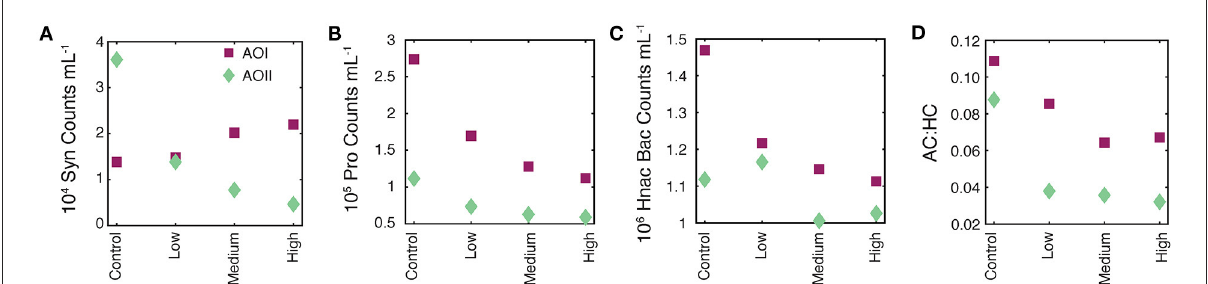
FIGURE3 Flow cytometry data on t 0 samples from all experimental treatments. In all panels, the magenta squares are AOI data and teal diamonds are AOII data. (A) 10 4 Synecococcus counts per mL. (B) 10 5 Prochlorococcus counts per mL. (C) 10 6 high nucleic acid bacterial (Hnac Bac) counts per mL. (D) Total autotrophic:heterotrophic count ratio [AC:HC = (Syn + Pro + Pico)/(Hnac Bac + Lnac Bac); see text for details].